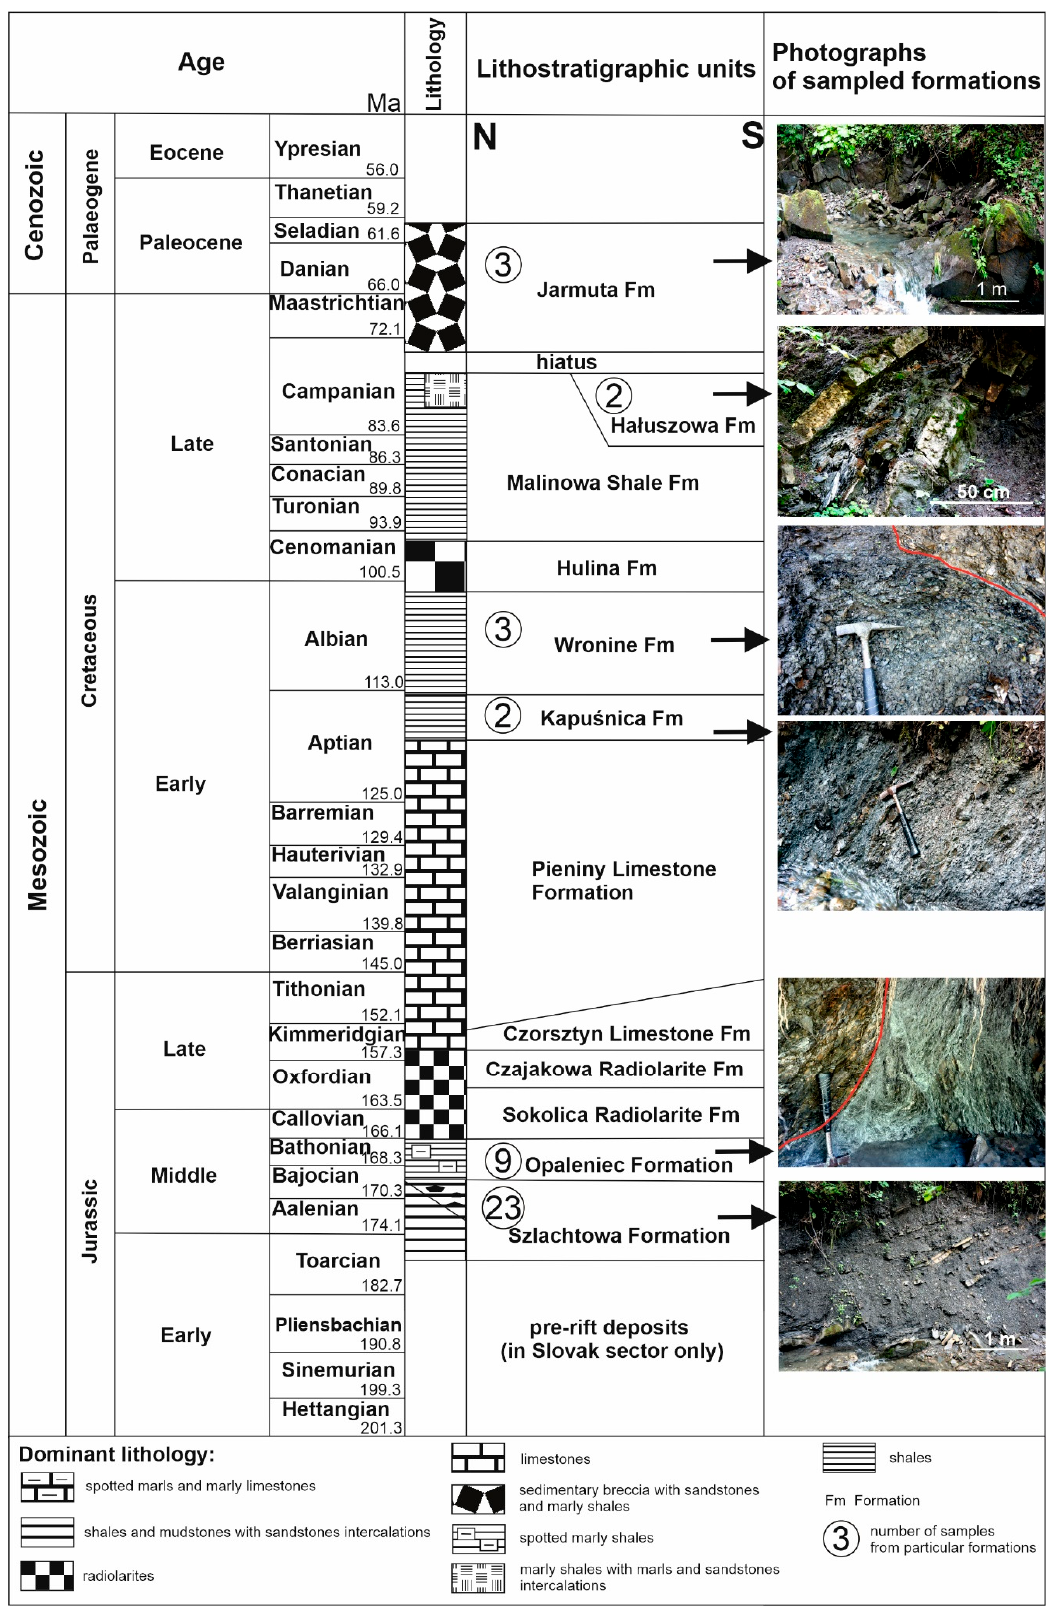
Figure 2. Lithostratigraphic scheme of the Grajcarek Succession in the Pieniny Klippen Belt (modified from [54]).